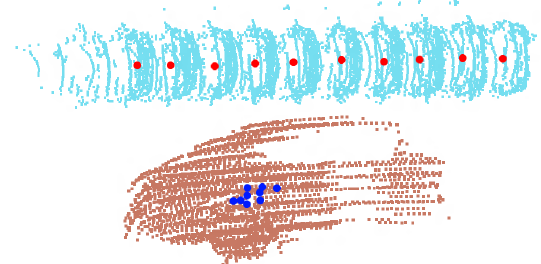
Figure 6: Representation of cendroid points distribution as a fea- ture. On the top the centroids follow big elongated line in case of moving vehicle, while on the bottom the centroids movements stay in a certain region.